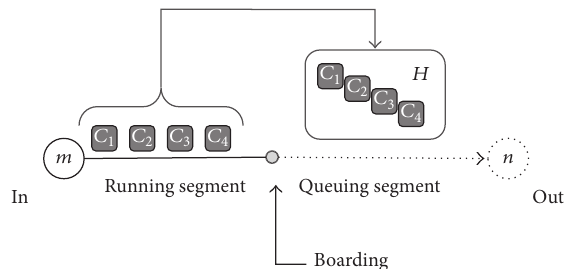
Figure 2: Scheme of the operations taking place in boarding arc.